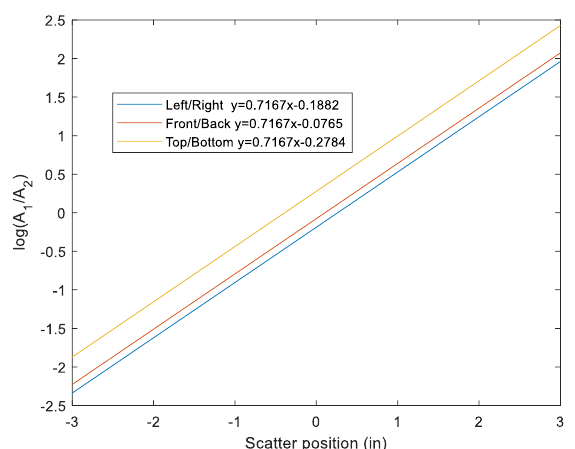
Fig. 3. Position calibration curves for opposite PMT neutron scatter events for the left/right (x), front/back (y), and top/bottom (z) PMT pairs. The linear curves were fit to the maximum/minimum achievable light ratios from the geometric end points at -3 and 3 inches determined from simulation.